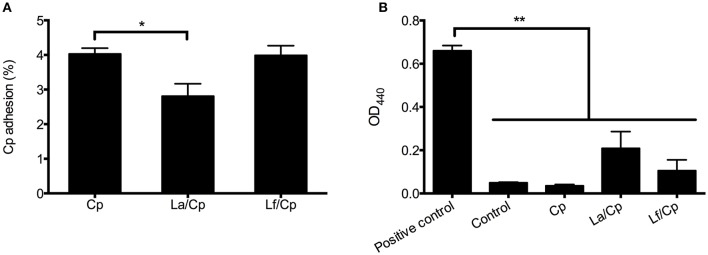
The effect of lactobacilli on the adhesion of C. perfringens to cells and the cytotoxicity induced by C. perfringens. Cells were pretreated with L. acidophilus or L. fermentum with multiplicity of infection (MOI) at 10 for 3 h and then infected with C. perfringens (MOI = 1) for 1 h. The percentage of C. perfringens adhered to cells were calculated (A) and LDH levels in the cell culture medium were detected (B). Data are presented as mean ± standard error (n = 3). *P < 0.05; **P < 0.01. La, L. acidophilus; Lf, L. fermentum; Cp, C. perfringens.